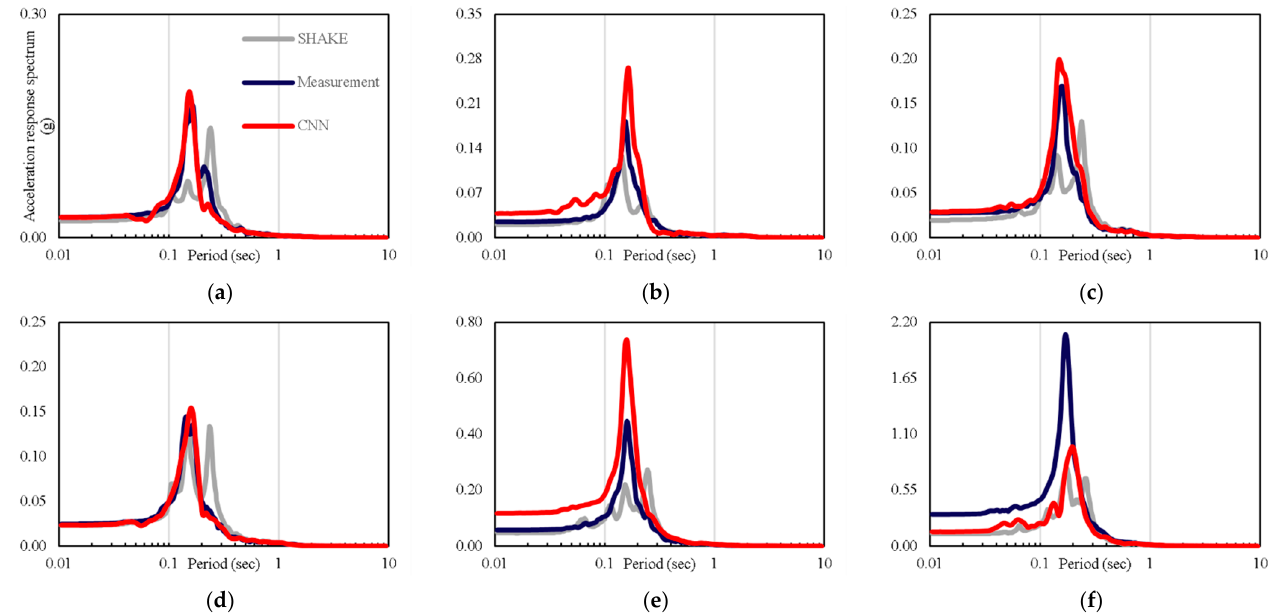
Figure 14. The six samples of acceleration response spectra measurements and predictions at site IWTH02. ( a )